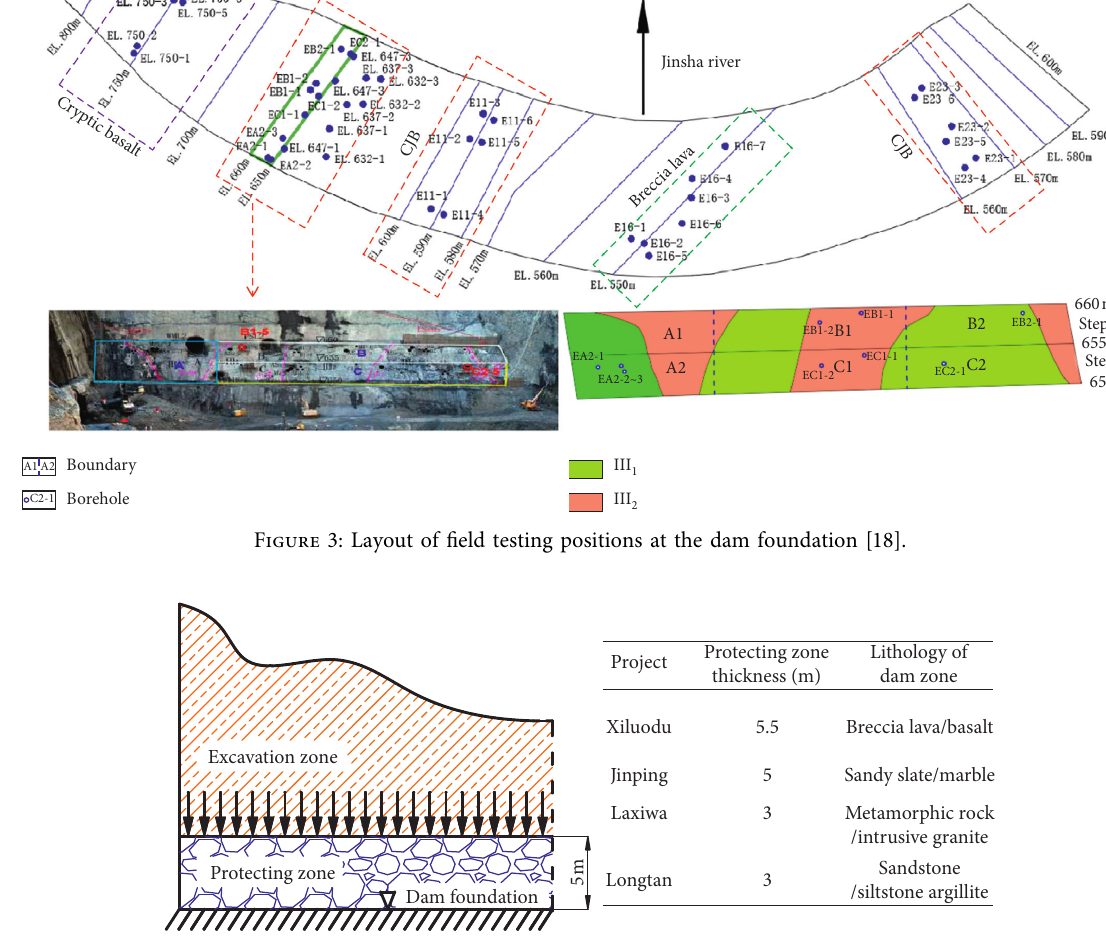
Figure 4: Sketch of dam foundation